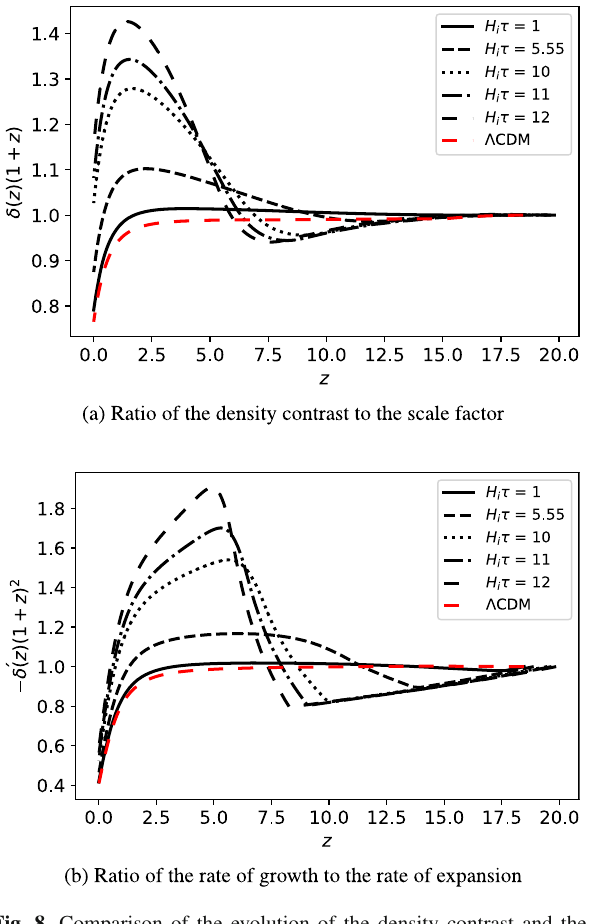
Fig. 8 Comparison of the evolution of the density contrast and the scale factor as well as their time rates of change